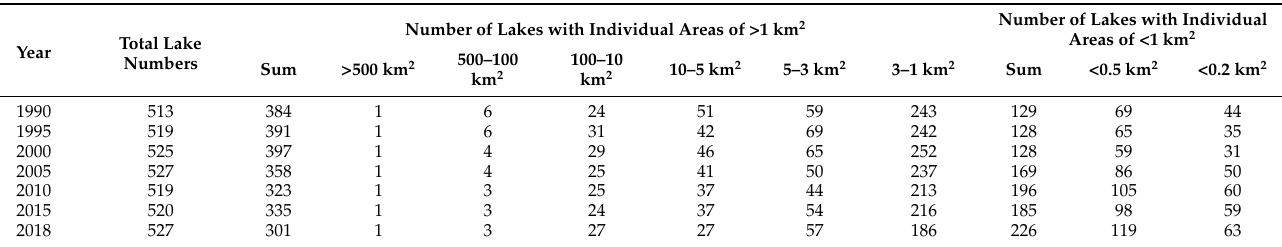
Table 2. Changes in the number of lakes in Inner Mongolia during